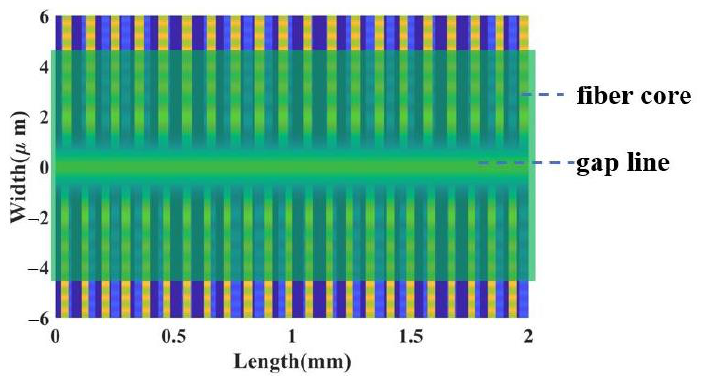
Figure 11. Near-field diffraction pattern of 2D spatially encoded phase mask and alignment relation- ship between fiber core and gap line of